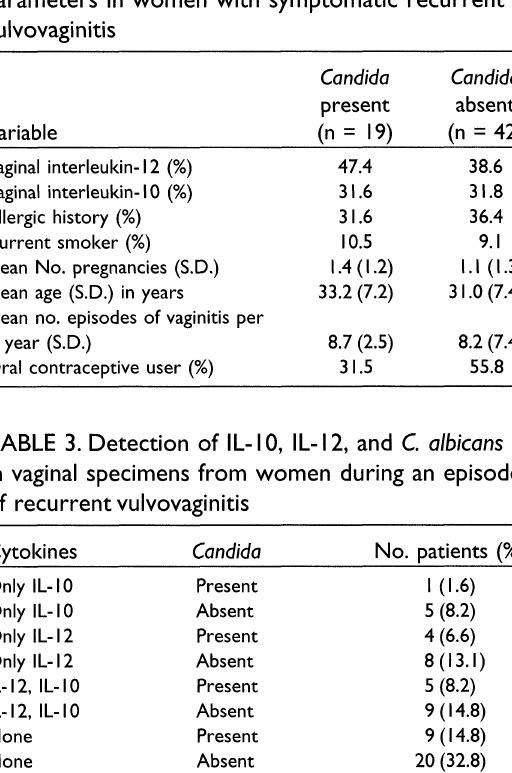
TABLE 2. Relation between C. albicans and various parameters in women with symptomatic recurrent